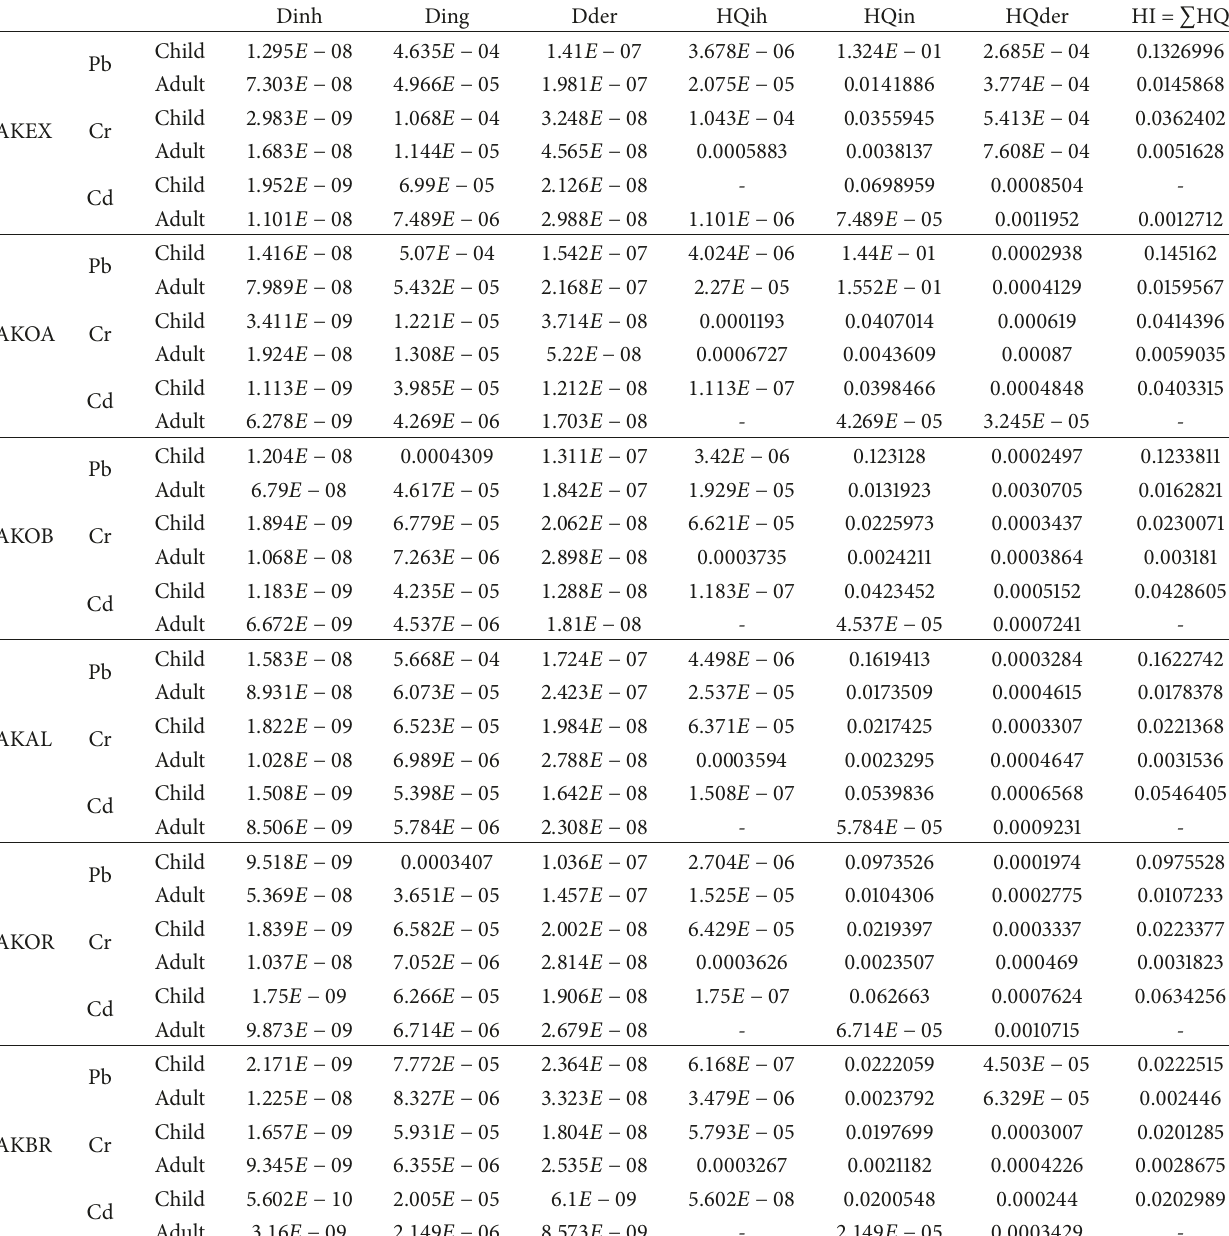
Table 6: Health risk from metals in dust for adults and children at various sampled sites of